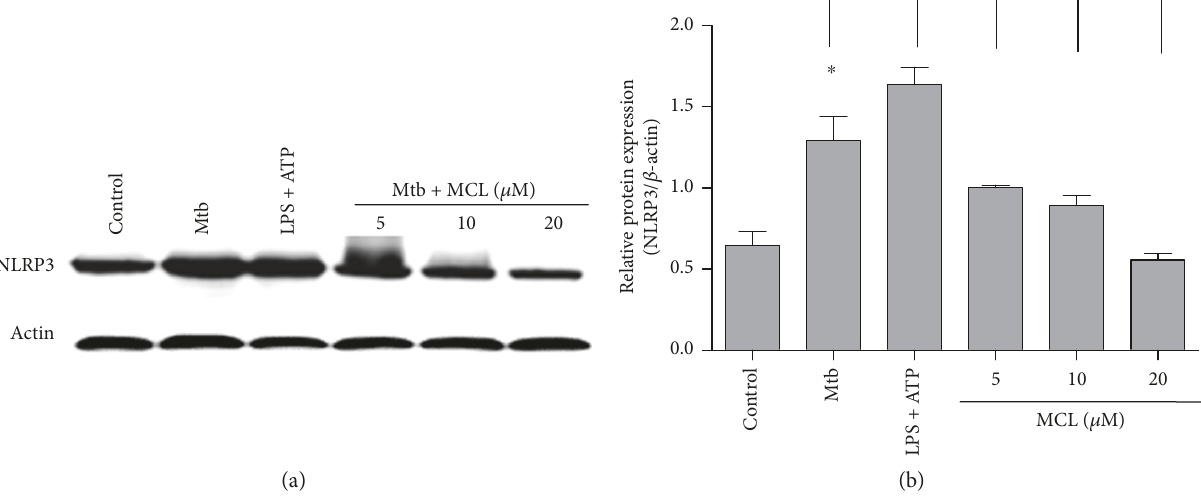
Figure 3: MCL inhibits Mtb-induced NLRP3 production. Raw264.7 cells (1 × 10 6 /well) were seeded in 6-well plates overnight and with H37Ra infection as mentioned before, and cells were then treated with MCL at the concentration (5, 10, and 20 μ M) for 12hr. (a) The protein expression of NLRP3 was detected by Western blot, and β -actin was used as an internal control. (b) The bar graphs showed the statistical results for NLRP3 expression. Data are presented as mean ± SD in at least three independent experiments, ∗ p < 0 05